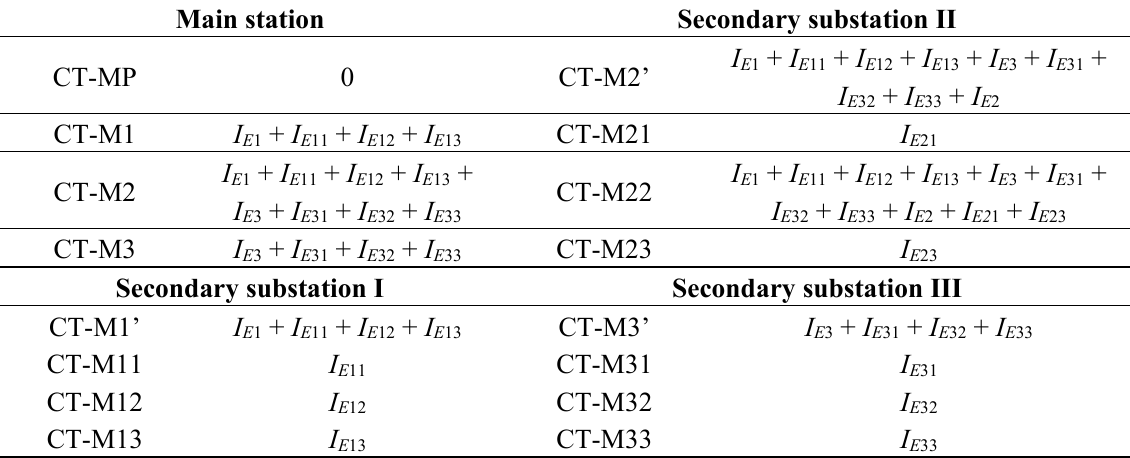
Table 1. Residual current measurements. Ground fault at Line 22—Phase “ a ”— rms current value